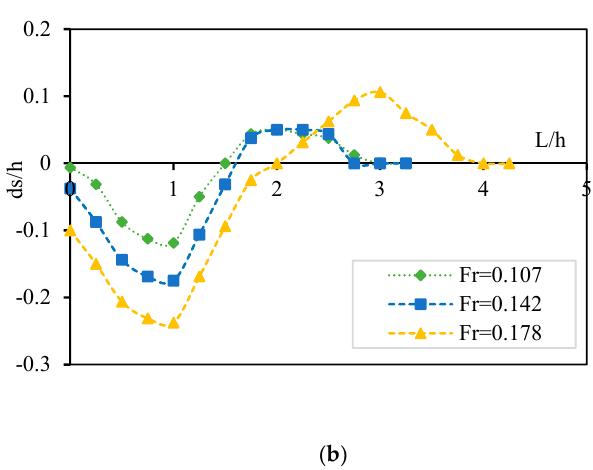
Figure 7. Comparison of the longitudinal profile of the bed for Run 2, Run 14, and Run 26: ( a ) y/W = 0.25 (left side); ( b ) y/W = 0.75 (right side).